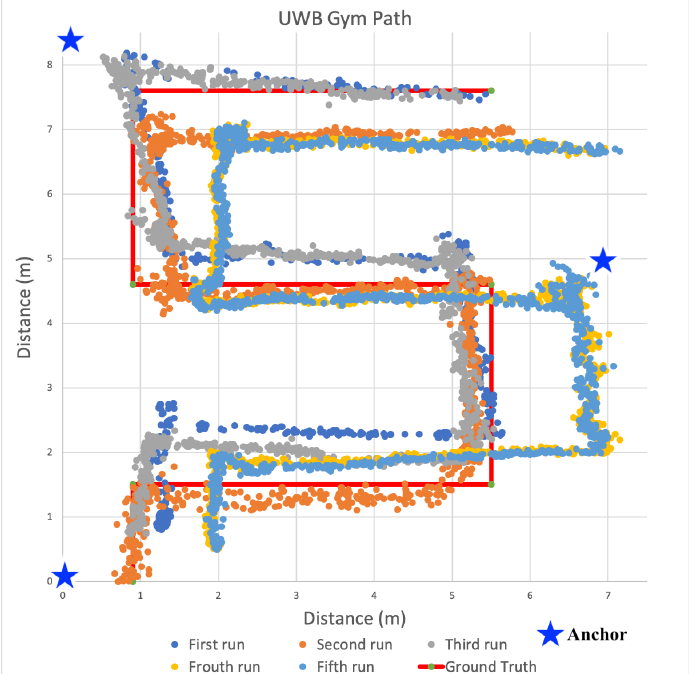
Figure 16. Position estimates obtained using two-way ranging localization with Ultra Wide Band in the open gymnasium space. Reference anchor locations used for localization are shown as stars and the solid red line constitutes the ground truth path. The different colored points show the calculated positions while traversing open gymnasium space during multiple successive